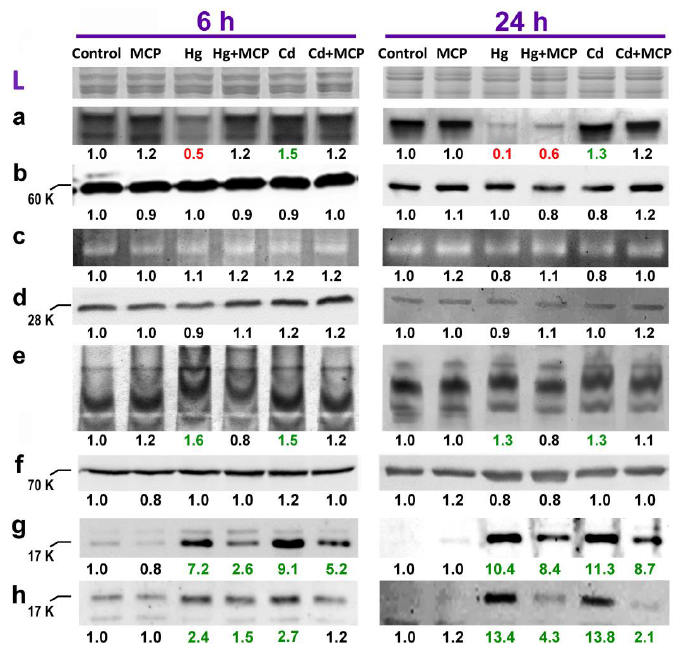
Figure 7. Functional analysis of ethylene-mediated responses to Hg and Cd in roots of alfalfa seedlings treated with 3 µM Hg or 30 µM Cd and supplemented with 10 µM 1-MCP, after 6 and 24 h treatment. Redox enzymatic activities and Small Heat Shock Proteins (sHSPs) immunostaining. Identification of bands labelled with lower case letters: GR activity ( a ), α -GR ( b ), APX activity ( c ), α -APX ( d ), NADPH-oxidase activity ( e ), α -HSP70 ( f ), α -sHSP17.7 ( g ), and α -sHSP17.6 ( h ). Apparent molecular weight (K, KDa) of proteins of interest is included on the left of the immunoblots. See legend Figure 3 for details of numbers’ annotation s.